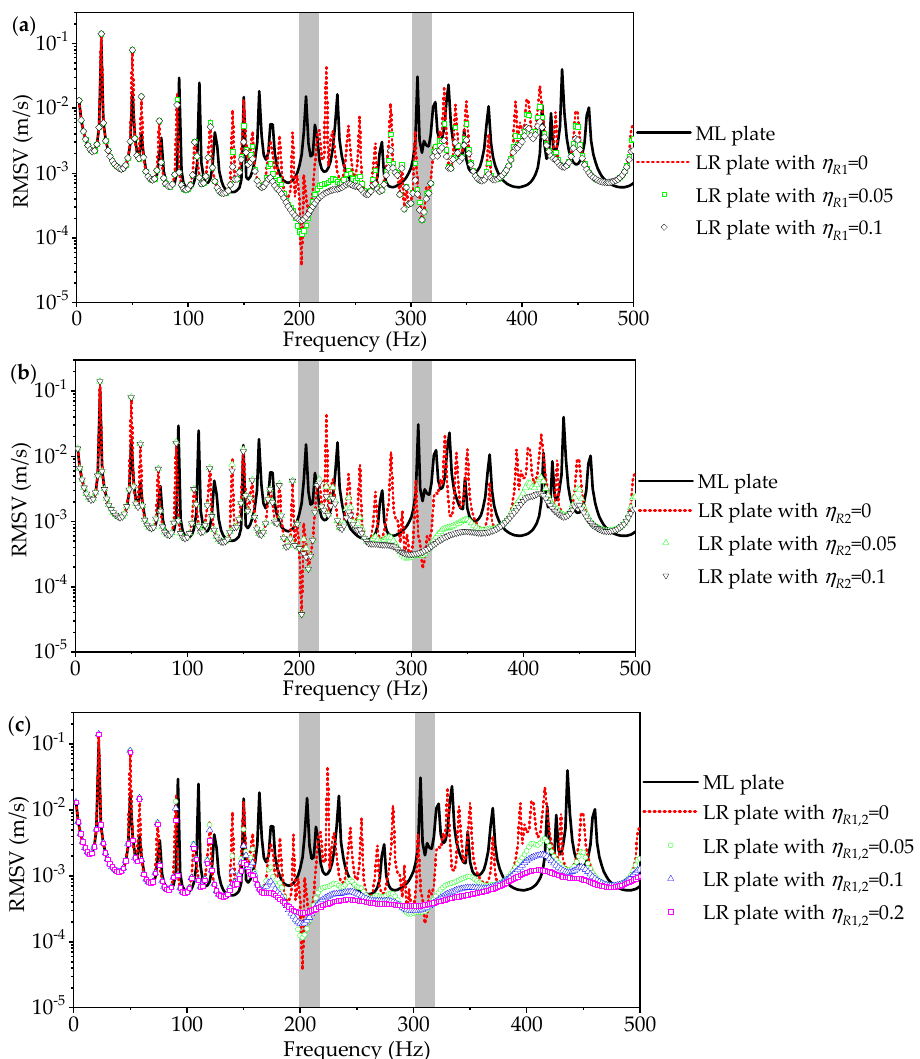
Figure 9. The root-mean-square velocities (RMSVs) averaged over the whole surface of the mass-loaded (ML) plate and the locally resonant (LR) plate with the resonator damping loss factors of ( a ) η R 1 varied by 0, 0.05, 0.1, and η R 2 kept as 0, ( b ) η R 1 kept as 0 and η R 2 varied by 0, 0.05, and 0.1, and ( c ) η R 1 and η R 2 simultaneously varied by 0, 0.05, 0.1, and 0.2.